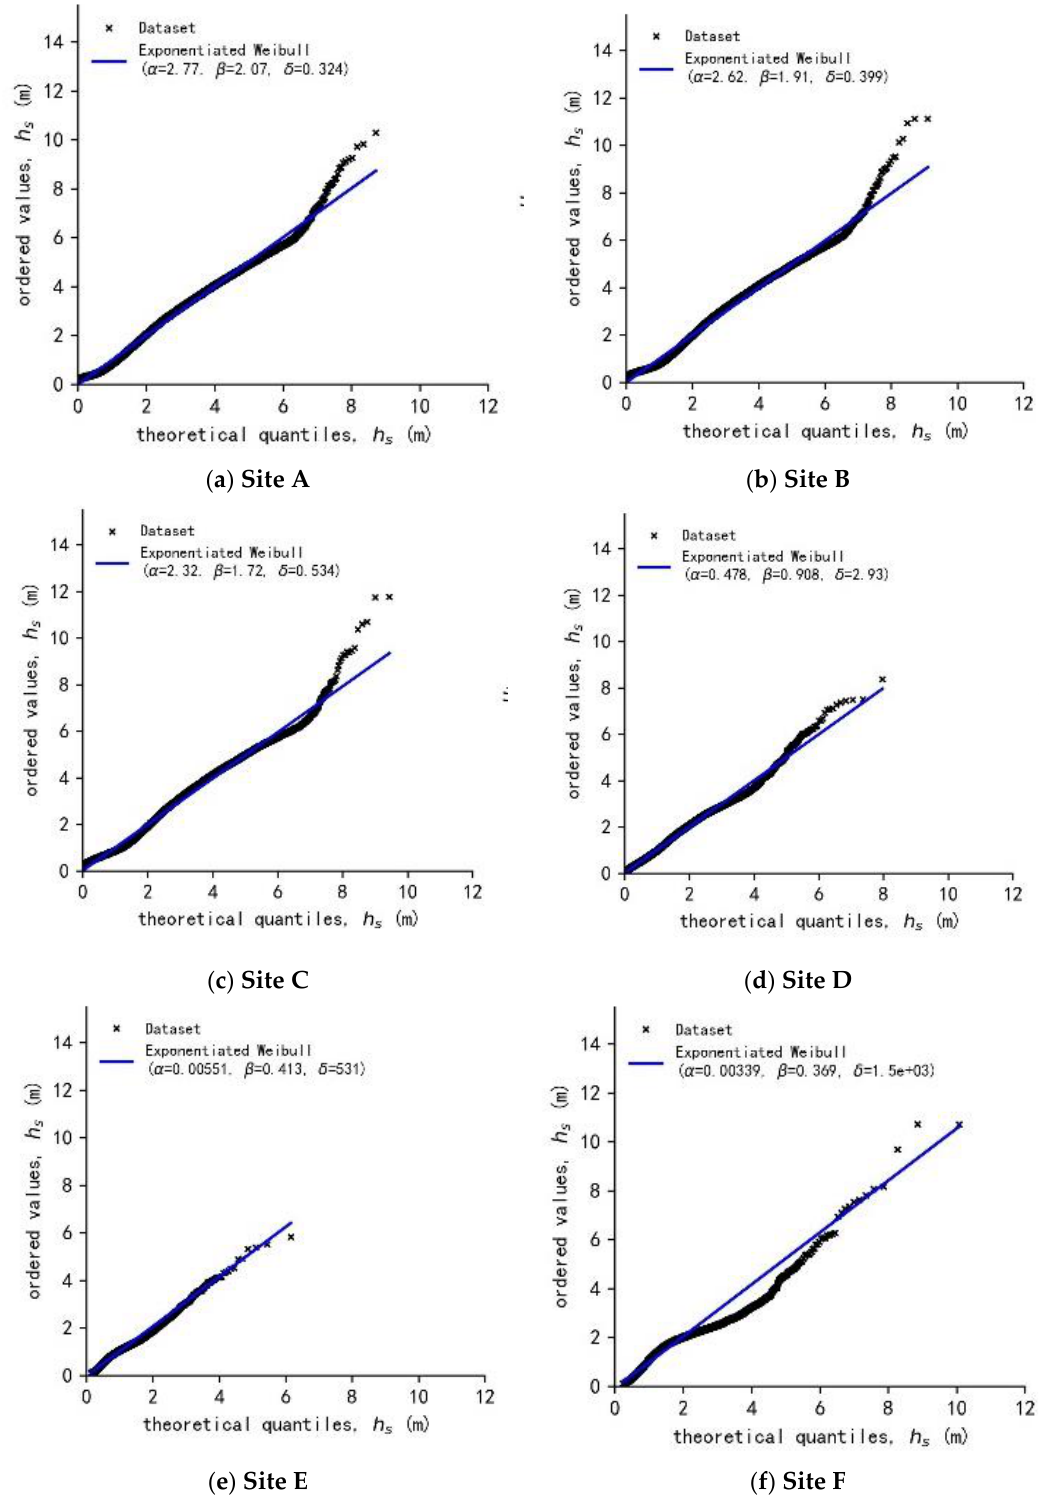
Figure 29. Fitting results of significant wave heights using the exponentiated Weibull distribution of sea-state parameters at reference sites in the Xisha Islands.